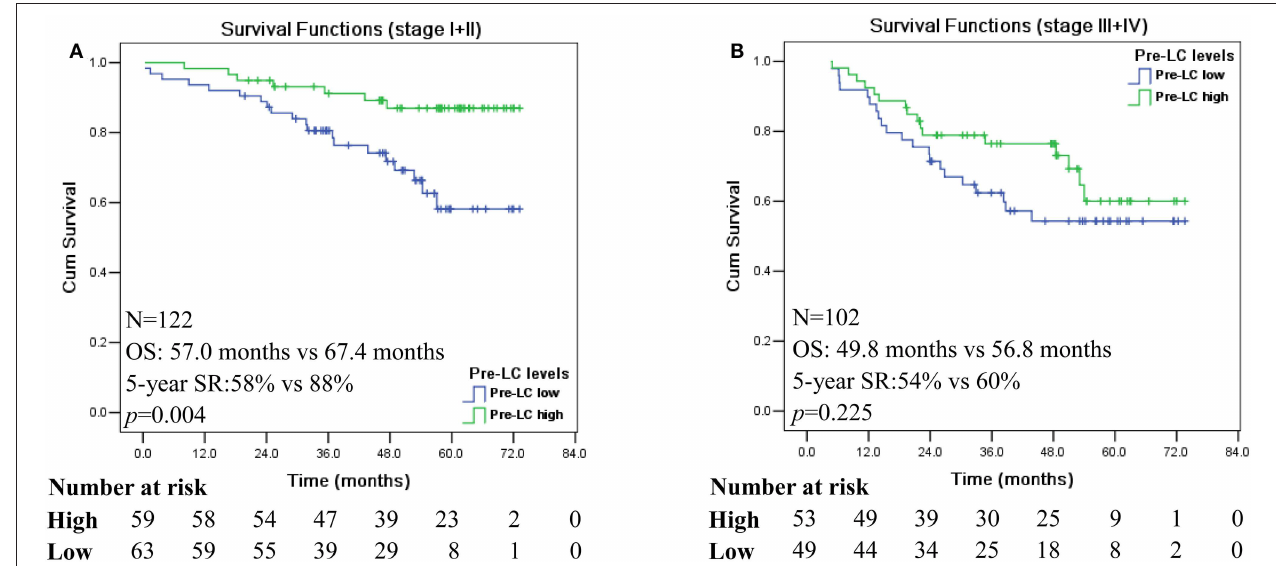
FIGURE 2 | Kaplan-Meier survival analysis of the high and low levels of pre-operation peripheral lymphocyte count in different disease stage of CRC patients. Comparison of overall survival between pre-LC high and pre-LC low among CRC patients with disease stage I + II (A) and disease stage III + IV (B) .